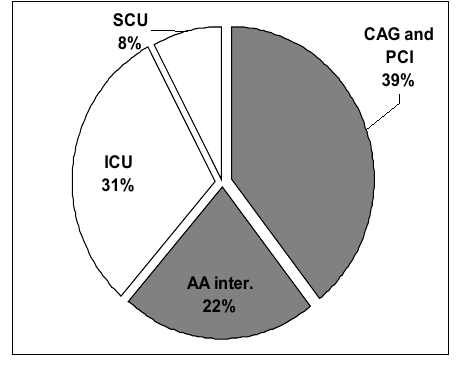
Figure 2. Contributors to the total in-patient costs.